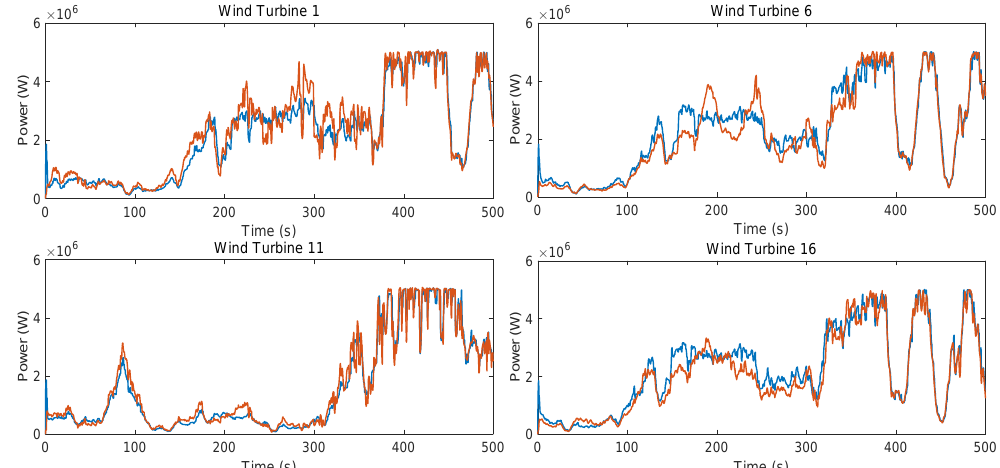
Figure 13. Power output comparison for wind turbines 1, 6, 11, and